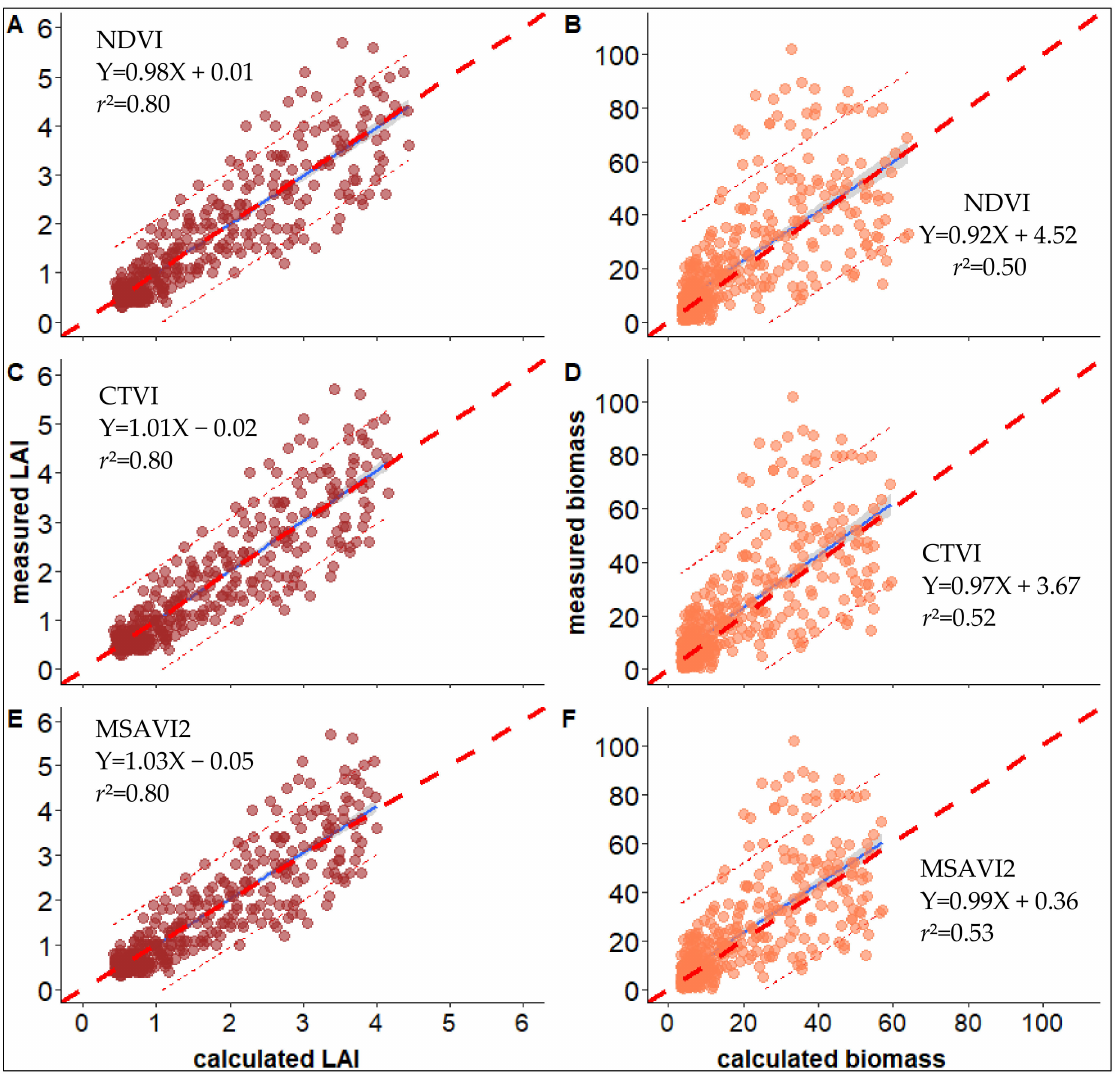
Figure 4. Calibration of measured and calculated (using vegetation indices) LAI (m 2 m − 2 ) and shoot biomass (g per plant) in 2018 field trial. Relationship between measured and calculated LAI from NDVI ( A ), CTVI ( C ), MSAVI2 ( E ); and calculated biomass from NDVI ( B ), CTVI ( D ), MSAVI2 ( F ). NDVI, CTVI and MSAVI2: vegetation indices; LAI: leaf area index; r 2 : coefficient of determination; the blue line is the regression line; the dashed dark red line in the graph is the 1:1 line; the dashed light red lines represent the 95% confidence interval of the